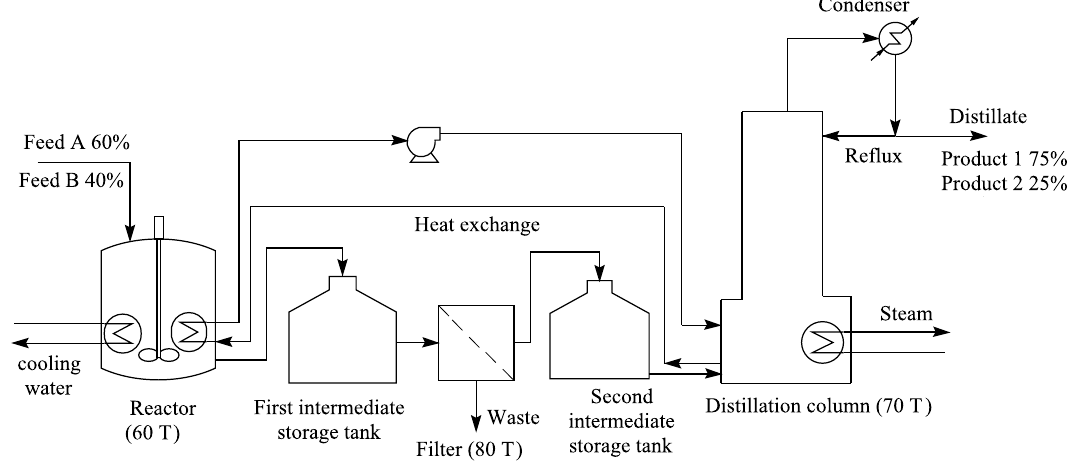
Figure 4. Heat-integrated batch reactor-separator (BR-S)